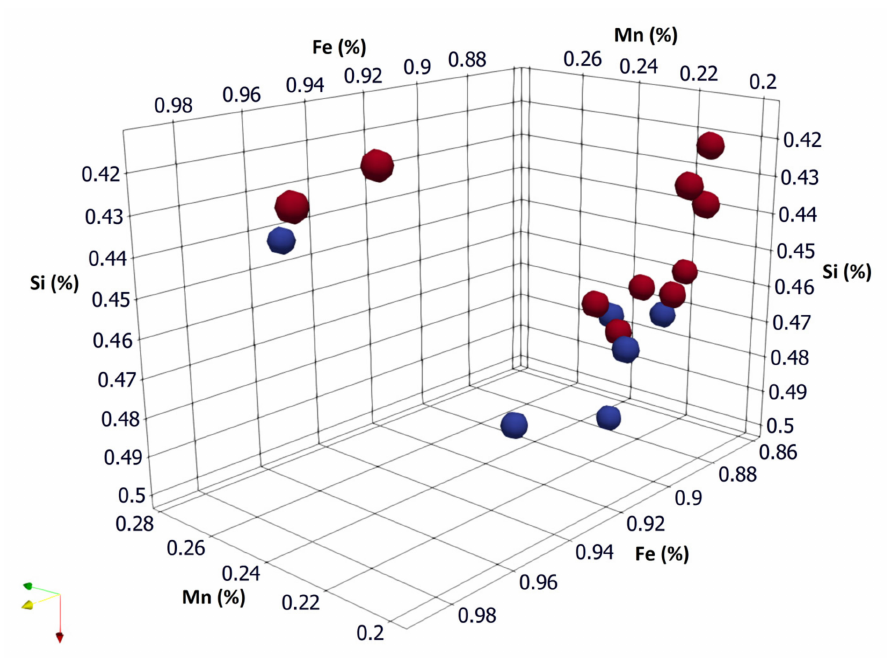
Figure 4. Visual comparison between coils with a high and a low short can index.